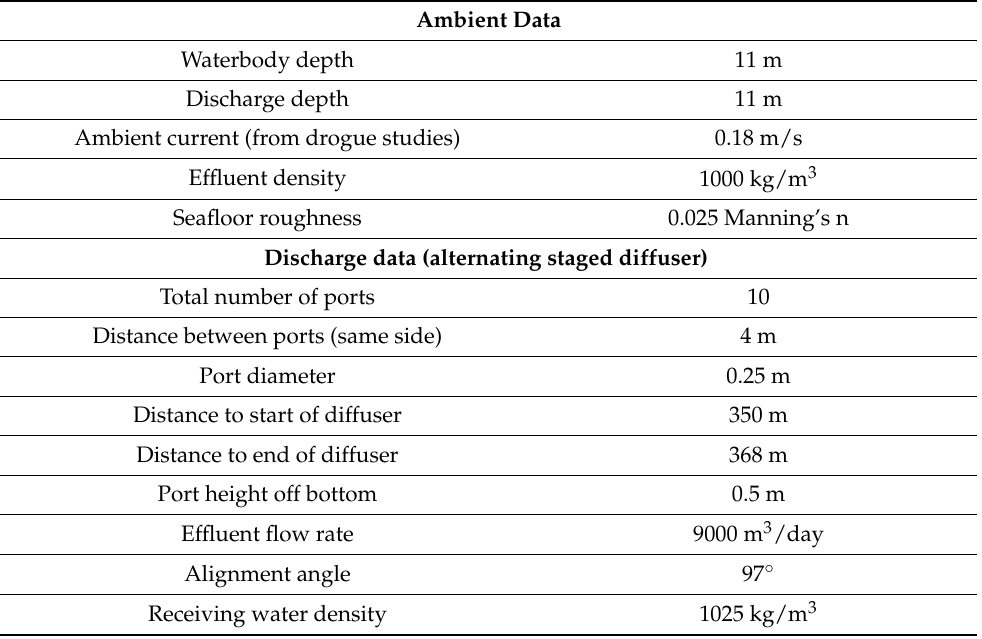
Table 3. Summary of input parameters for the CORMIX mixing zone